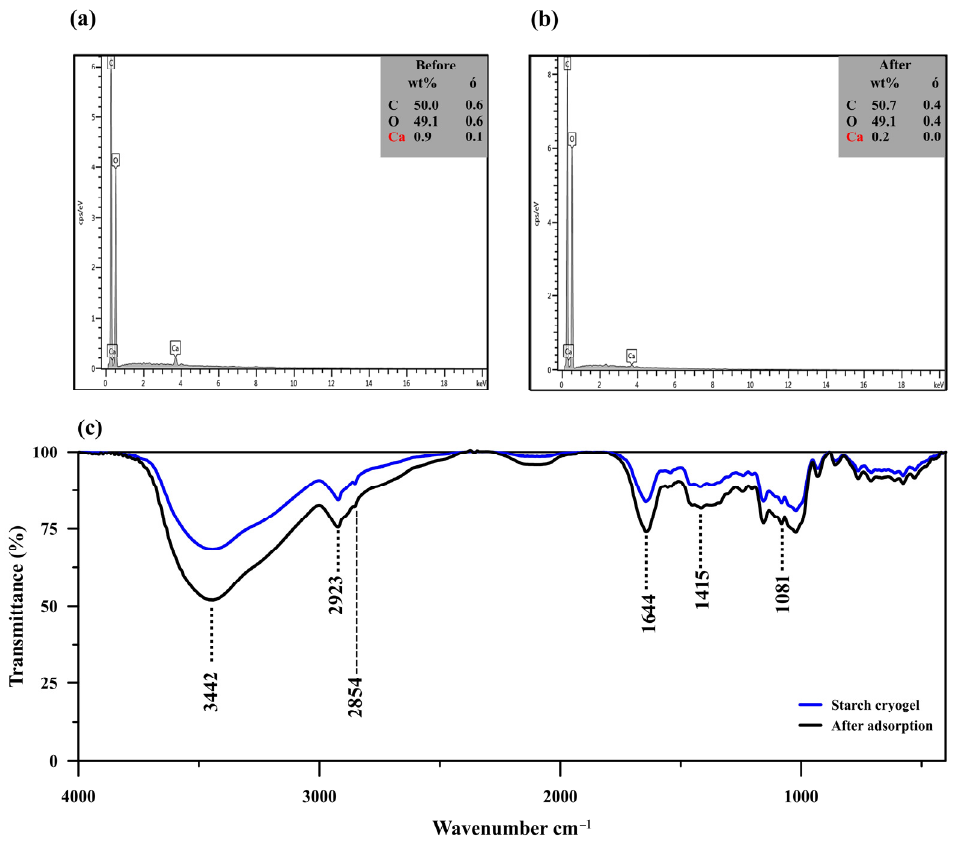
Figure 2. ( a , b ) Energy-dispersive X-ray spectra of starch cryogel before ( a ) and after methylene blue (MB) adsorption ( b ). ( c ) Fourier-transform infrared spectra of starch cryogel before and after MB adsorption.